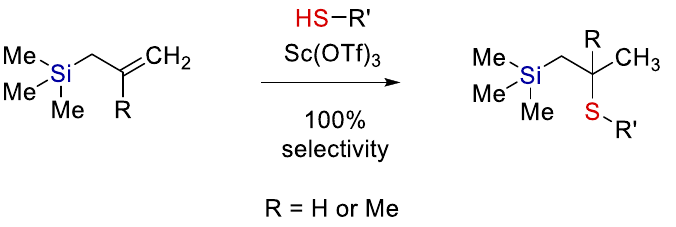
Figure 1. A scheme of ionic thiol-ene addition [15]. Adopted from Ref.